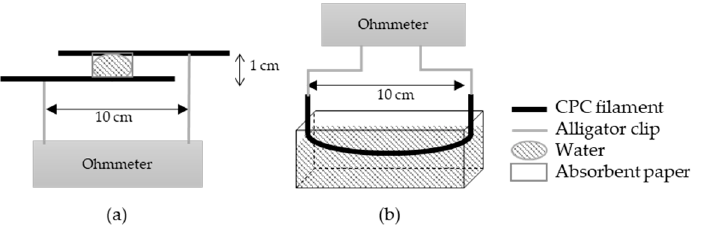
Figure 1. Scheme of the principle of detection by the short circuit ( a ) and by absorption ( b ).